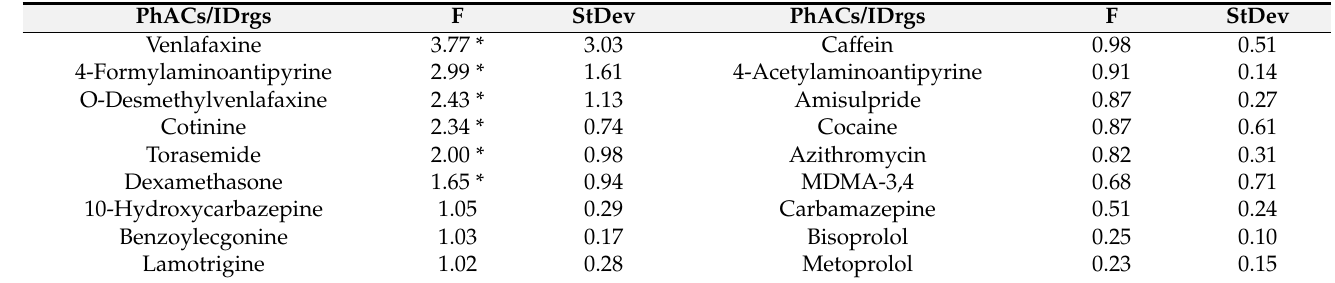
Table 2. Loss in PhACs/IDrgs mass flows in Sava River during lockdowns. *—PhACs/IDrgs with F ≥ 1.5.